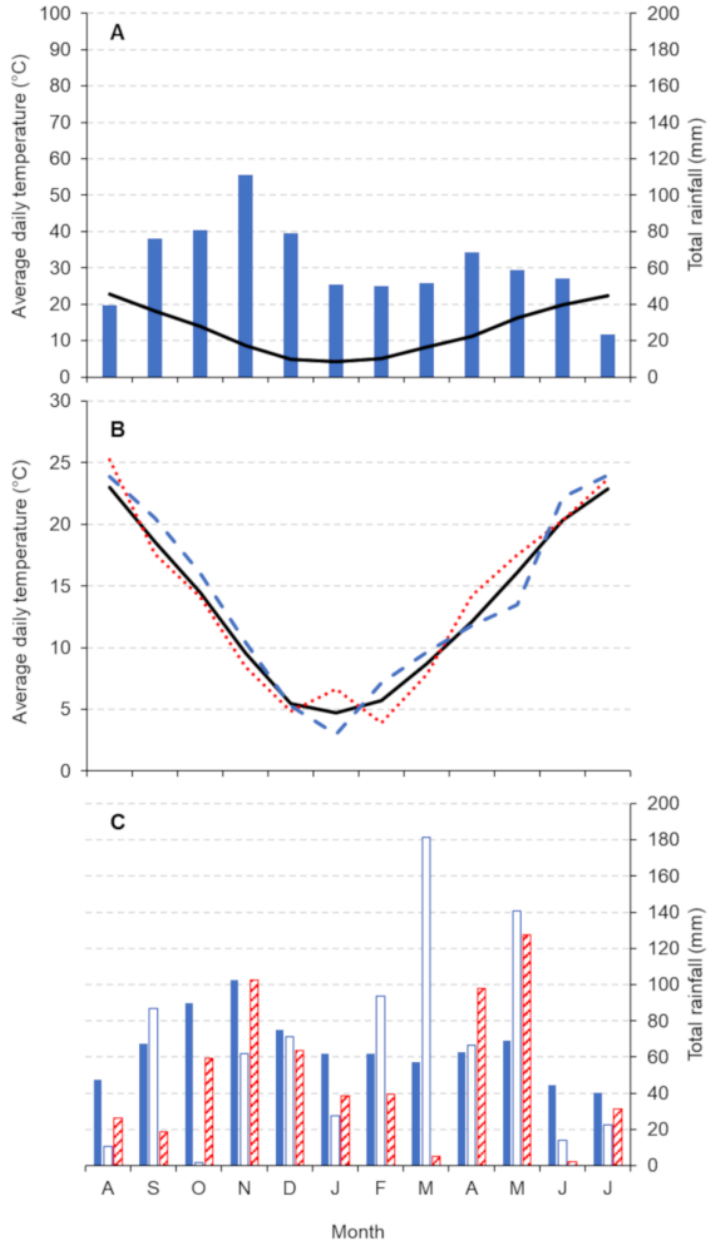
Figure 2. ( A ) Walter-Lieth climate diagram of the study site (data 2001 – 2020), with monthly daily average temperature (°C, black continuous line) and monthly average rainfall amount (mm, histo- grams). ( B ) Comparison of the monthly daily average temperature (mm) measured during 2001 – 2020 (continuous line), 1st growing season (dashed line) and 2nd growing season (dotted line); ( C ) comparison of the monthly rainfall amount (mm) measured during 2001 – 2020 (color-filled histo- grams), 1st growing season (hollow histograms) and 2nd growing season (diagonal-filled histo- grams).